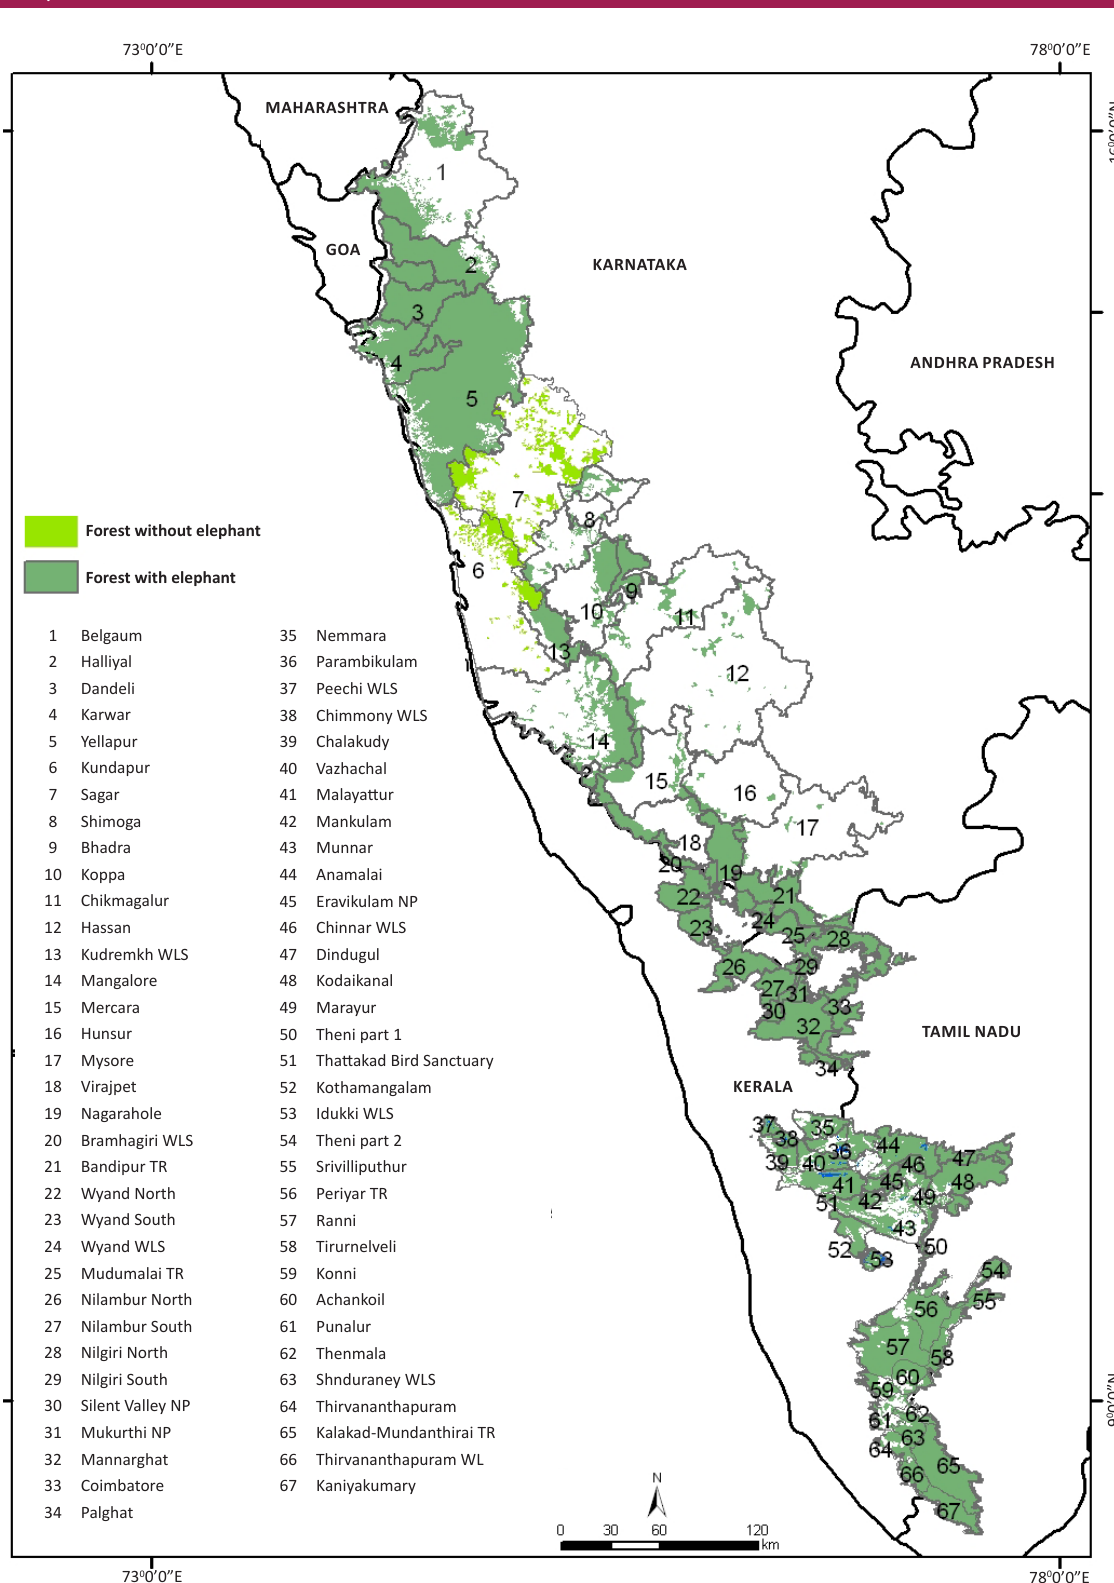
1. Map showing the distribution of elephants in the Western Ghats under different forest divisions in southern India (excluding Maharashtra and Goa). Note: Forest divisions such as Gudalur in Tamil Nadu, Aralam WLS, Kannore and Calicut in Kerala have elephants but are not shown in the distribution map due to non-availability of SI topographic map. WLS, NP and TR refer to Wildlife Sanctuary, National Park and Tiger Reserve